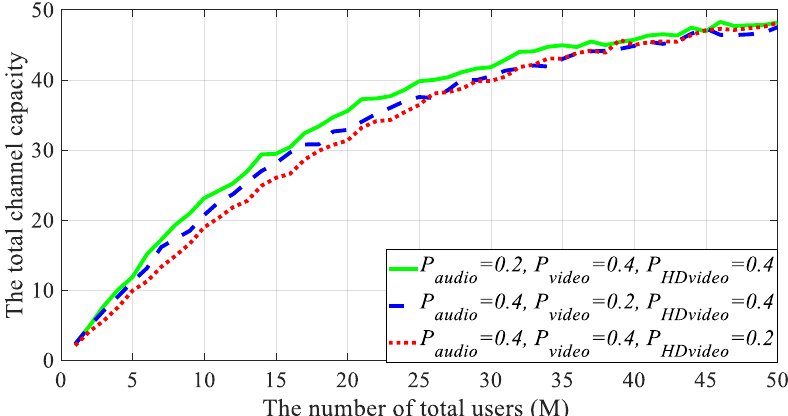
Figure 9. The grouping successful rate of the single relay-allowed modified pilot-based grouping method in scenario 3.